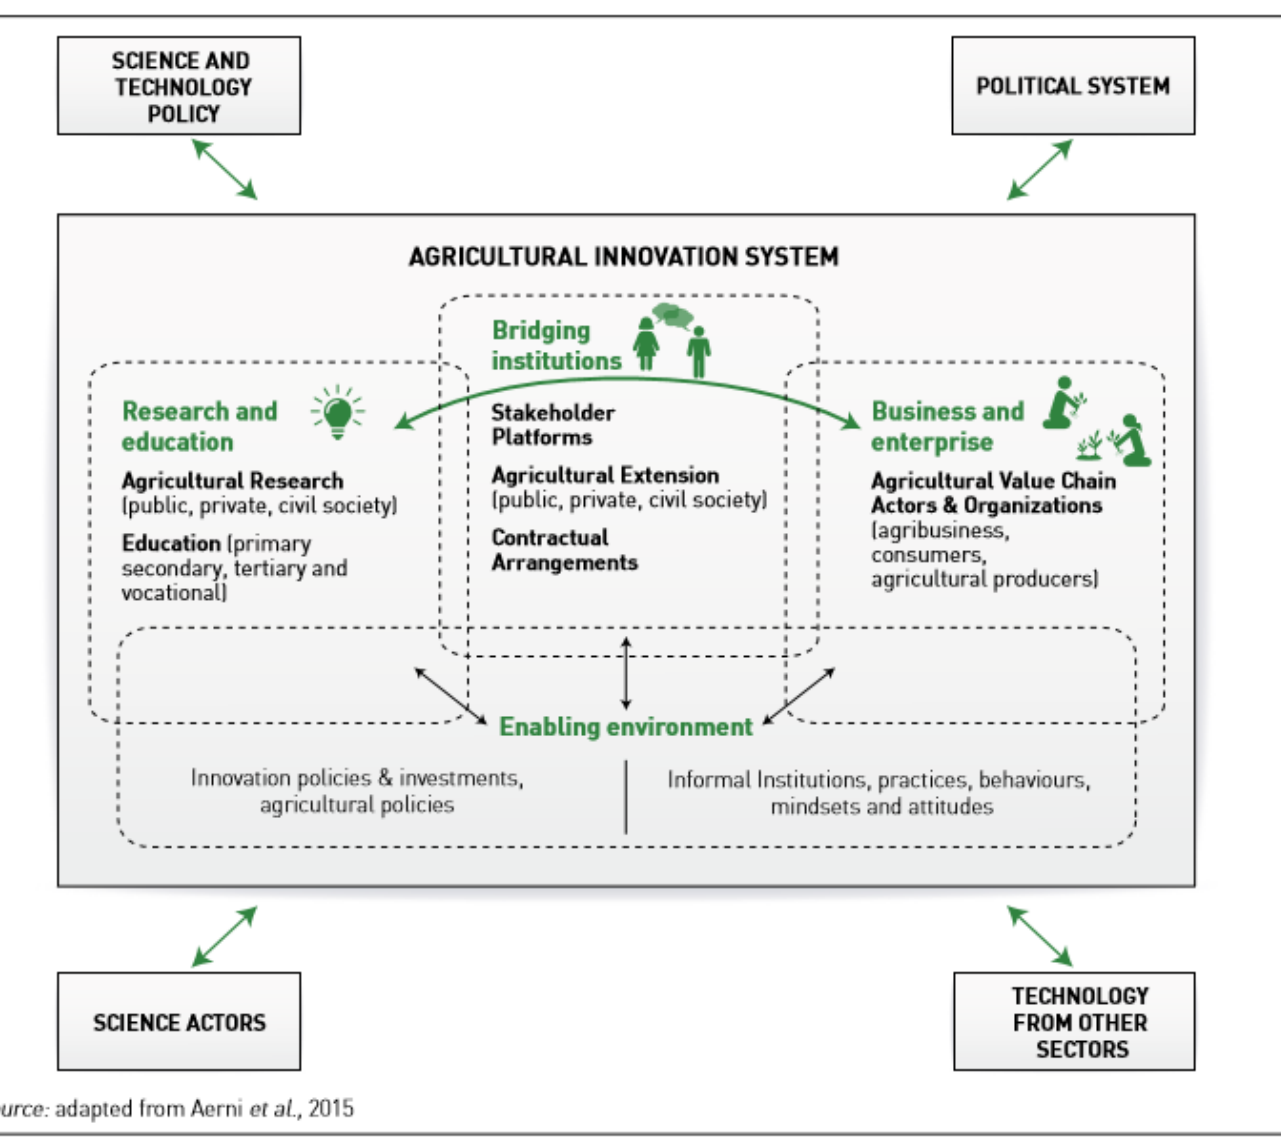
Conceptual diagram of an Agricultural Innovation